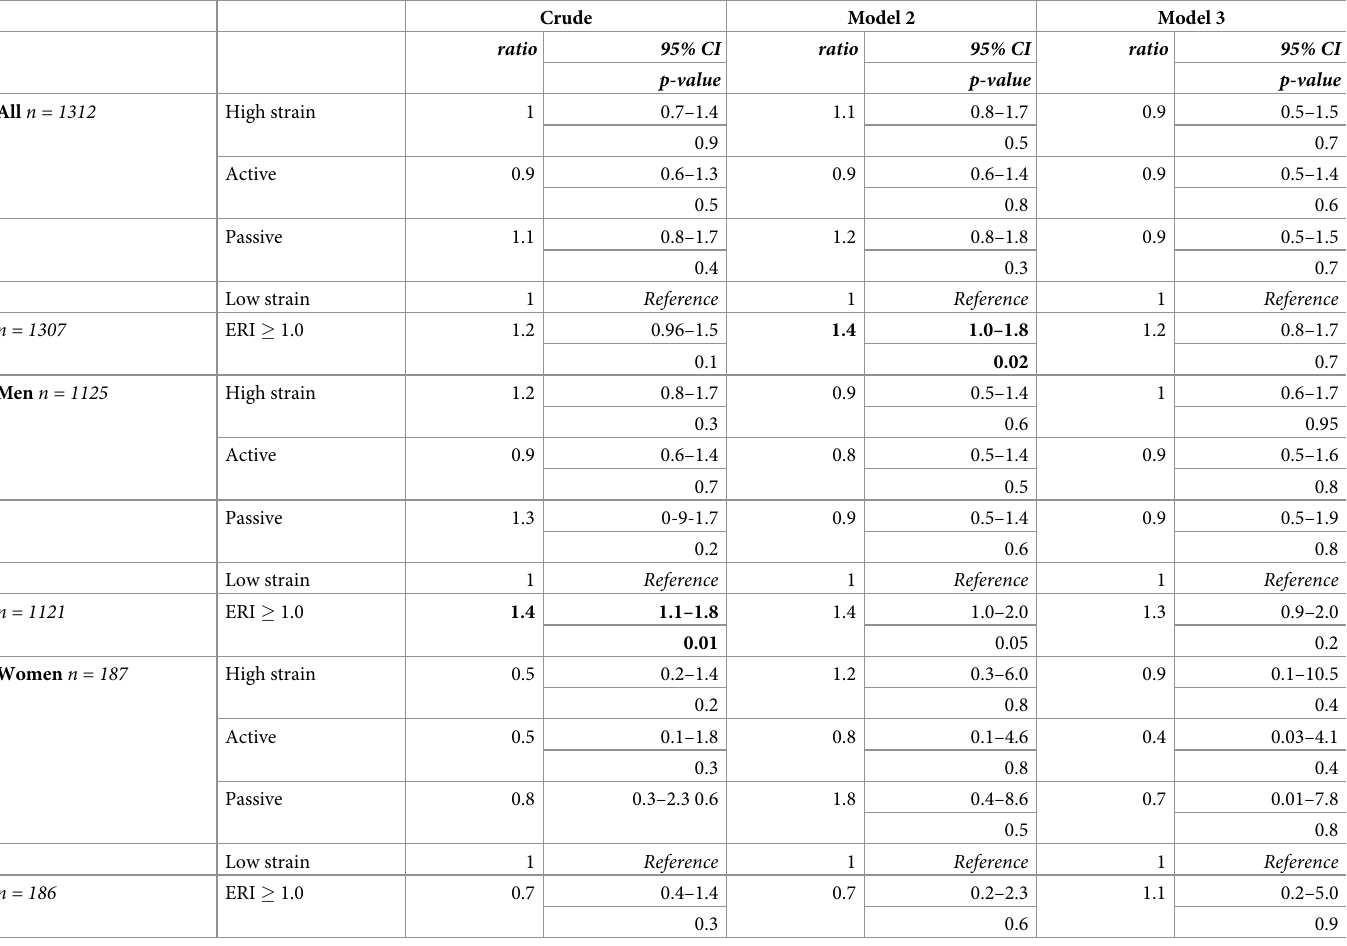
Table 2. Regression analyses of psychosocial conditions between cases with extended work � 63 years and controls who retired � 62